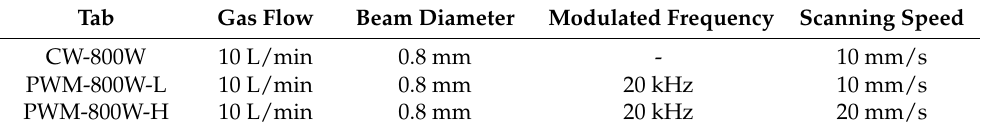
Table 2. Parameters of laser.